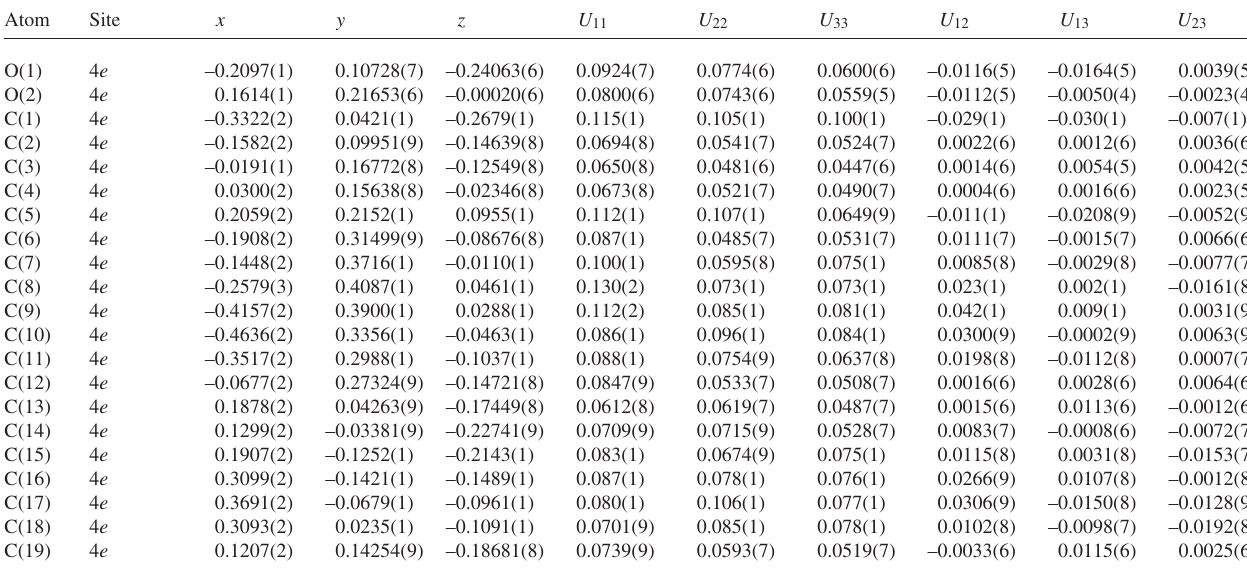
Table 3. Atomic coordinates and displacement parameters (in Å 2 )